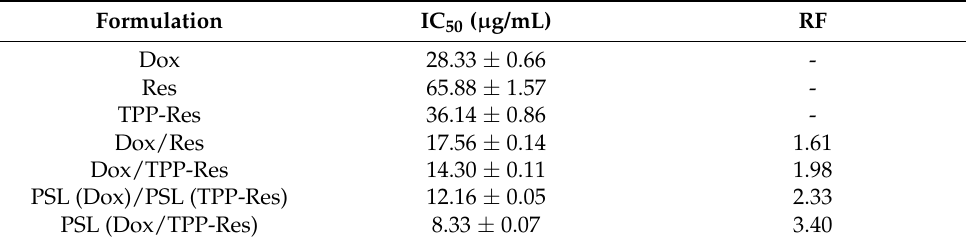
Table 2. The IC 50 and resistance factor (RF) on the